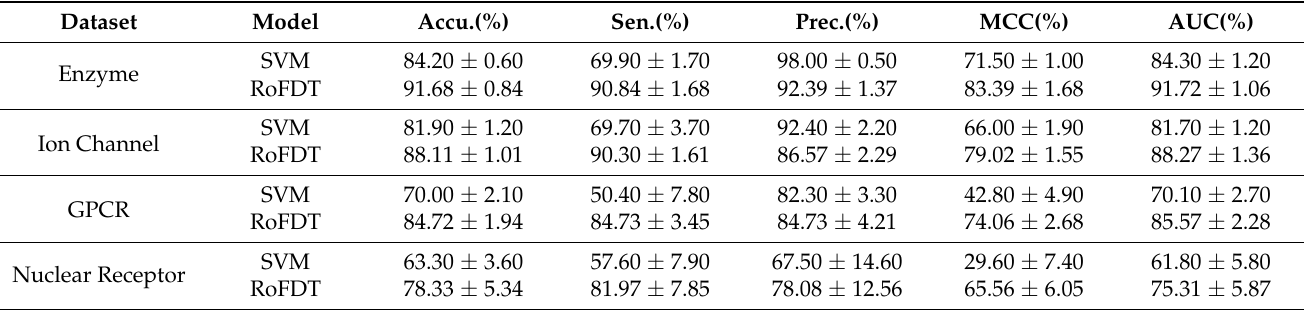
Table 6. 5FCV outcomes of different classifier models on the four gold standard